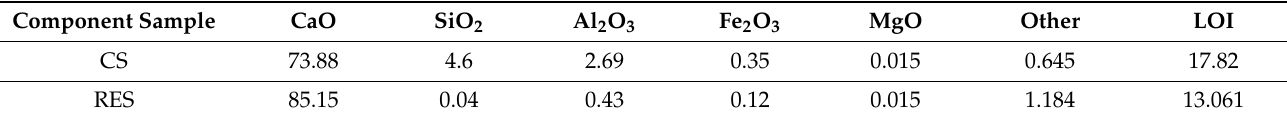
Figure 2. X-ray diffraction results of sorbents. Table 2. The chemical composition of samples (wt %).